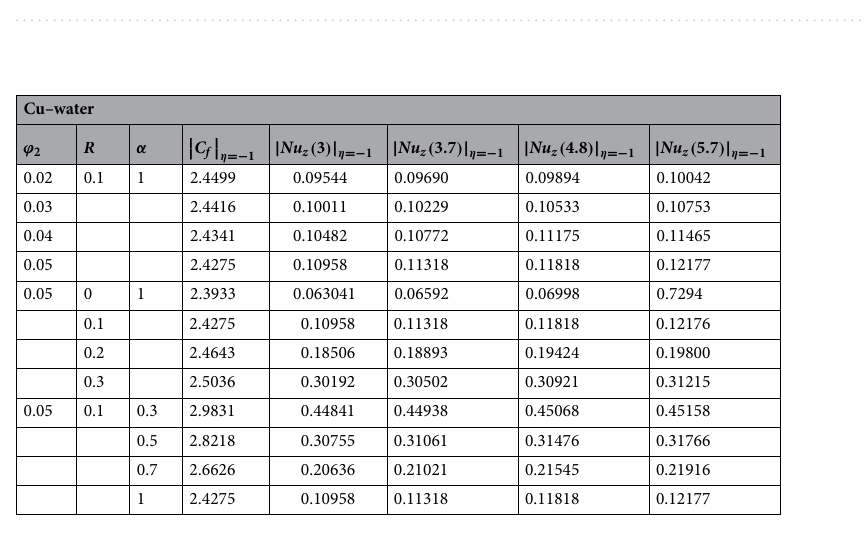
Table 2. Effect of shape and size factor of HN fd on heat transfer coefficient by fixing ϕ 1 = ϕ 2 = 0.01, Sc = 1, M = 1, R = − 1, Pr = 6.2, α = − 1 .